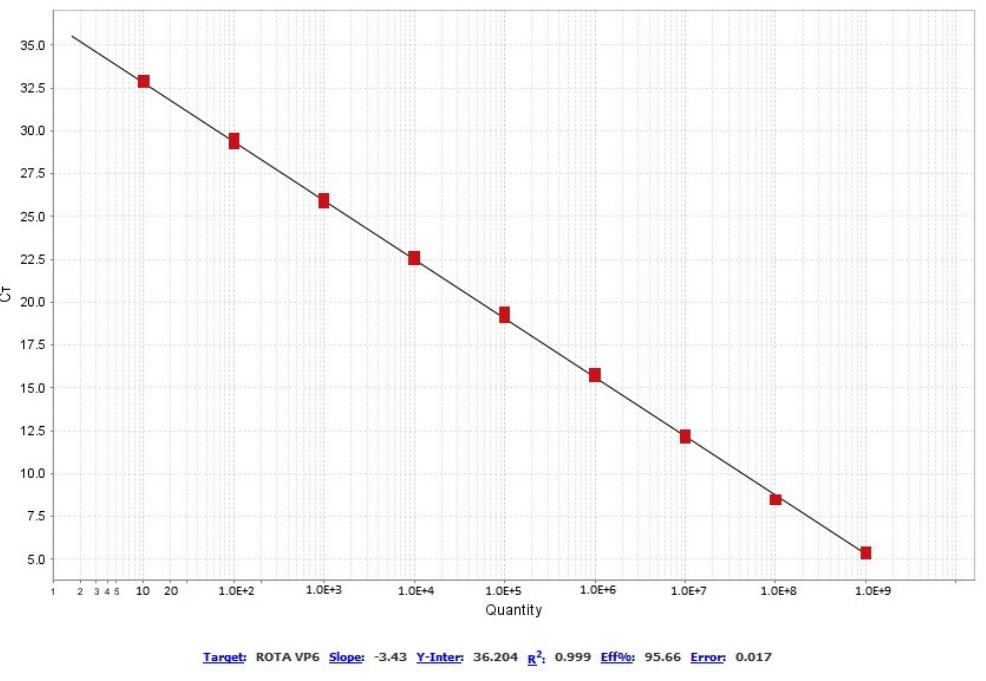
Figure 4. Standard curve diagram. Table 2. Reproducibility of the RT-qPCR assay used for the detection of the VP6 gene of ARtV-A. Concentration of the RT-PCR